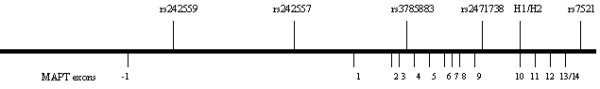
Scheme of MAPT genomic structure showing the position of the 6 SNPs genotyped.